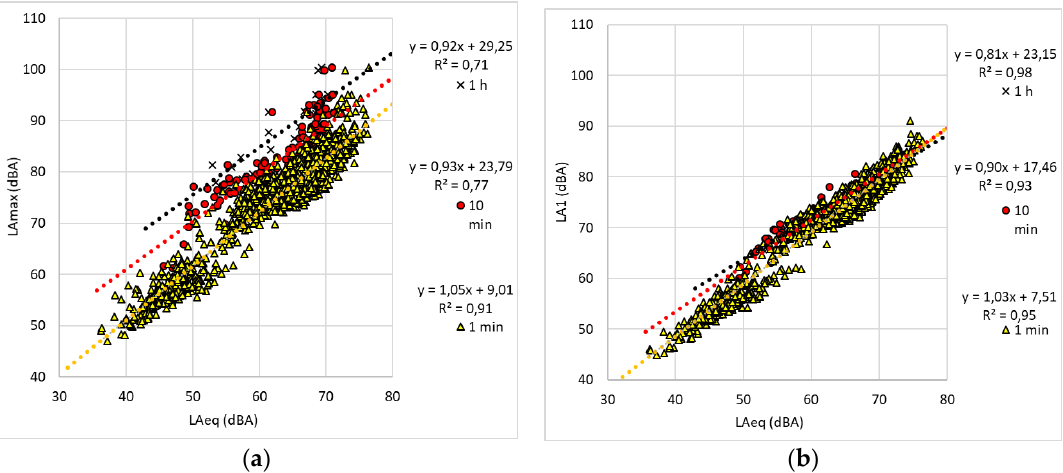
Figure 1. Linear regression between L Amax and L Aeq ( a ) and L A1 and L Aeq ( b ) measured in a street at different time intervals (1 h, 10 min and 1 min).